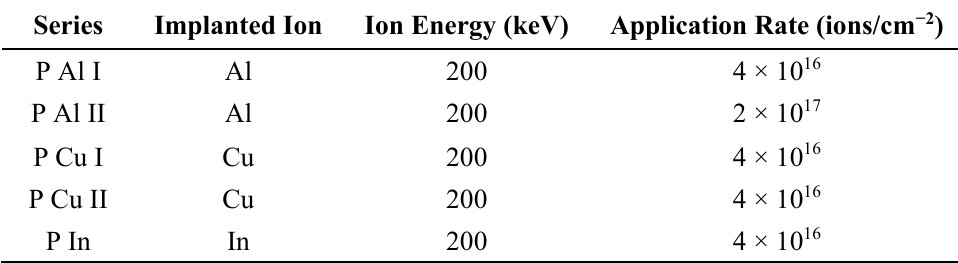
Table 3. Implantation conditions for the elements Al, Cu and